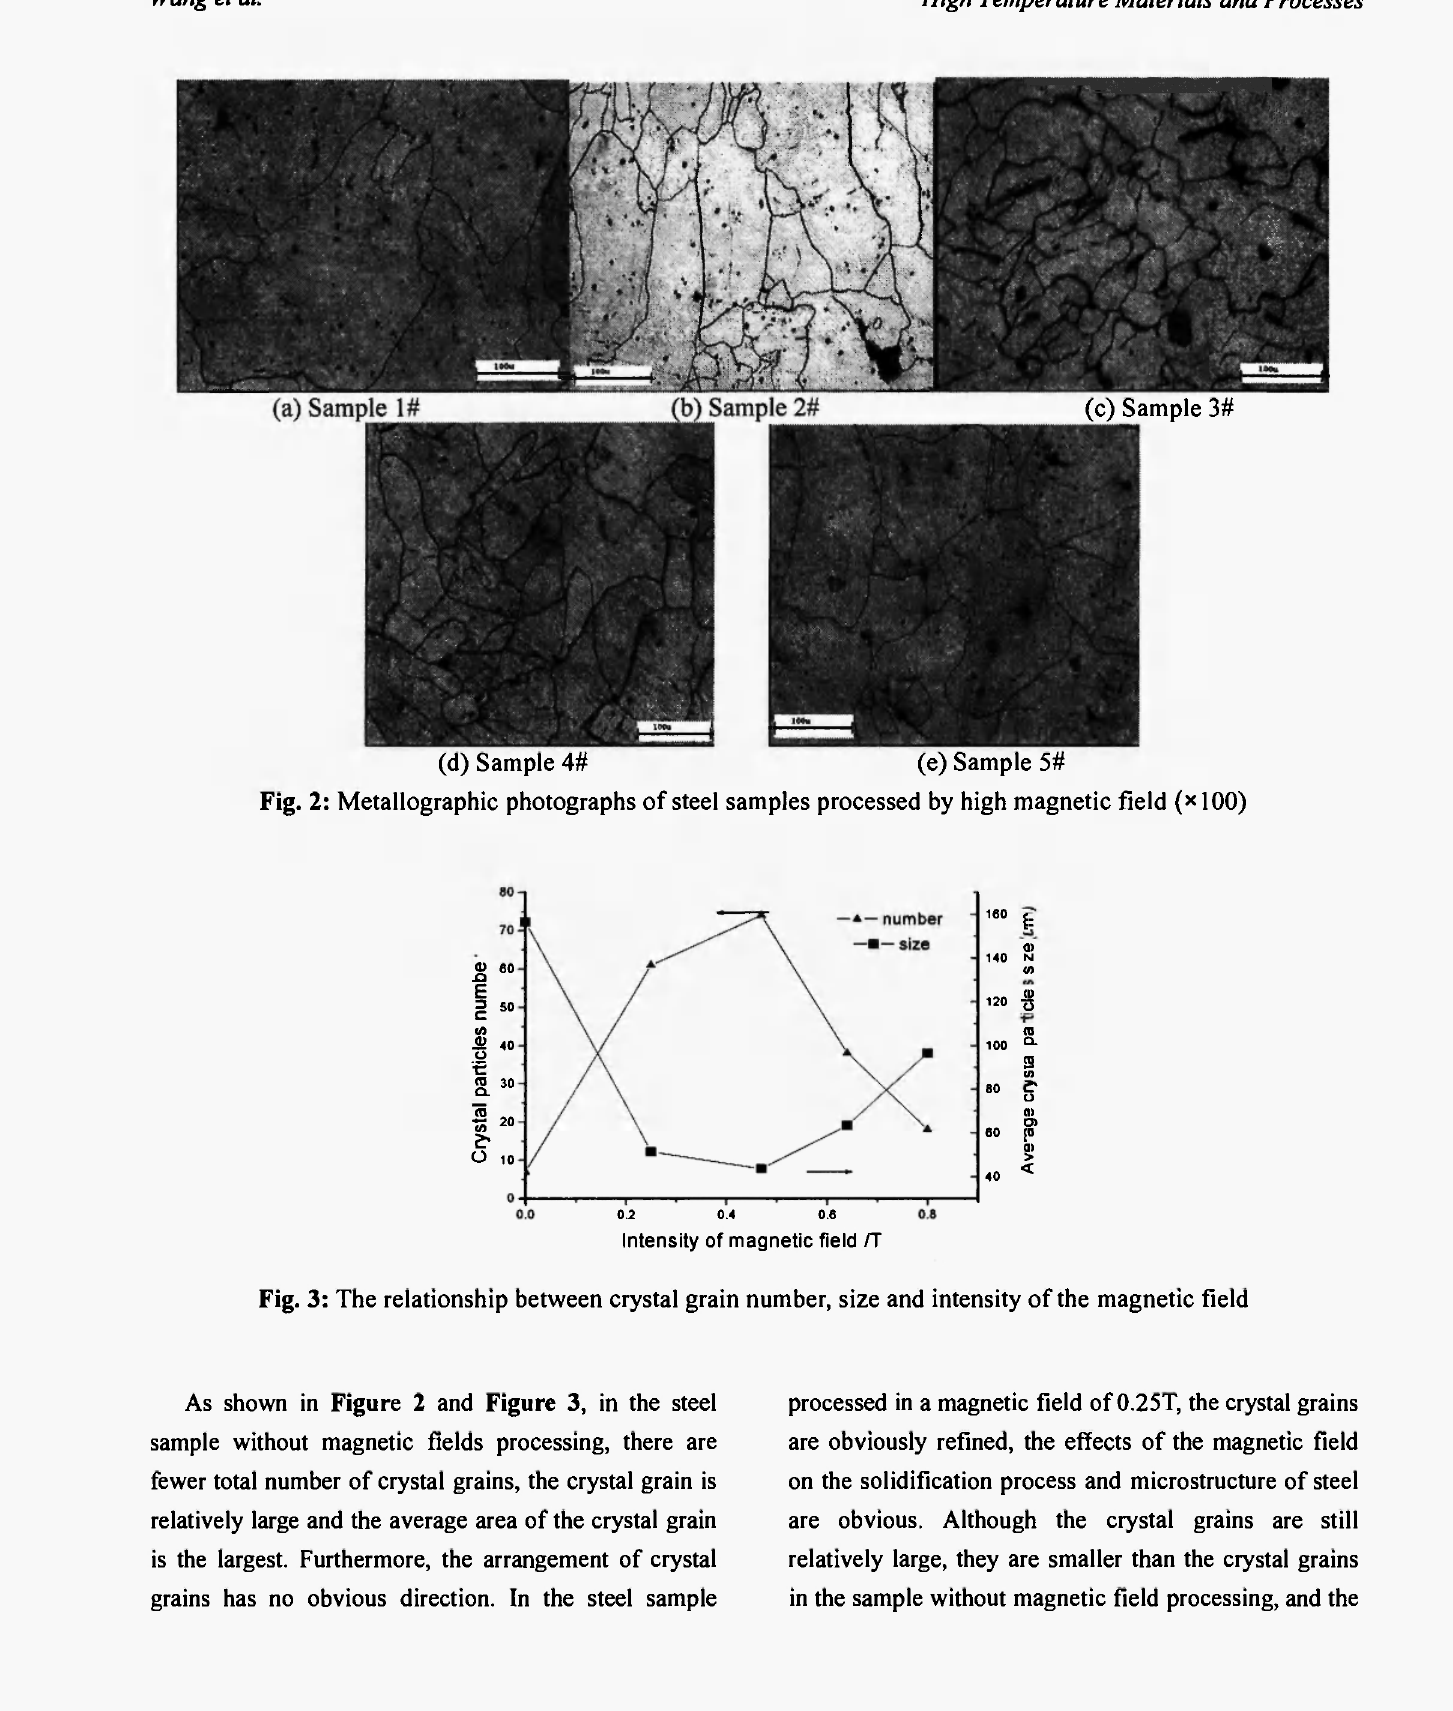
As shown in Figure 2 and Figure 3, in the steel sample without magnetic fields processing, there are fewer total number of crystal grains, the crystal grain is relatively large and the average area of the crystal grain is the largest. Furthermore, the arrangement of crystal grains has no obvious direction. In the steel sample